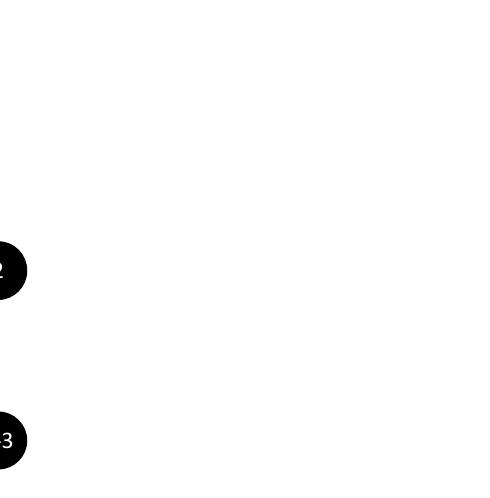
Figure 2. Chloroplast DNA haplotype network based on the TCS method. The five haplotypes and subtypes found in Q. hondae are denoted by solid circles, and the six haplotypes and subtypes found in Q. glauca by open circles. Black bars indicate single base mutations and grey bars indicate differences in mononucleotide repeats. The sizes of the circles are approximately proportional to the sample sizes. Table 2. A comparison of genetic diversity per locus between Q. hondae and Q. glauca